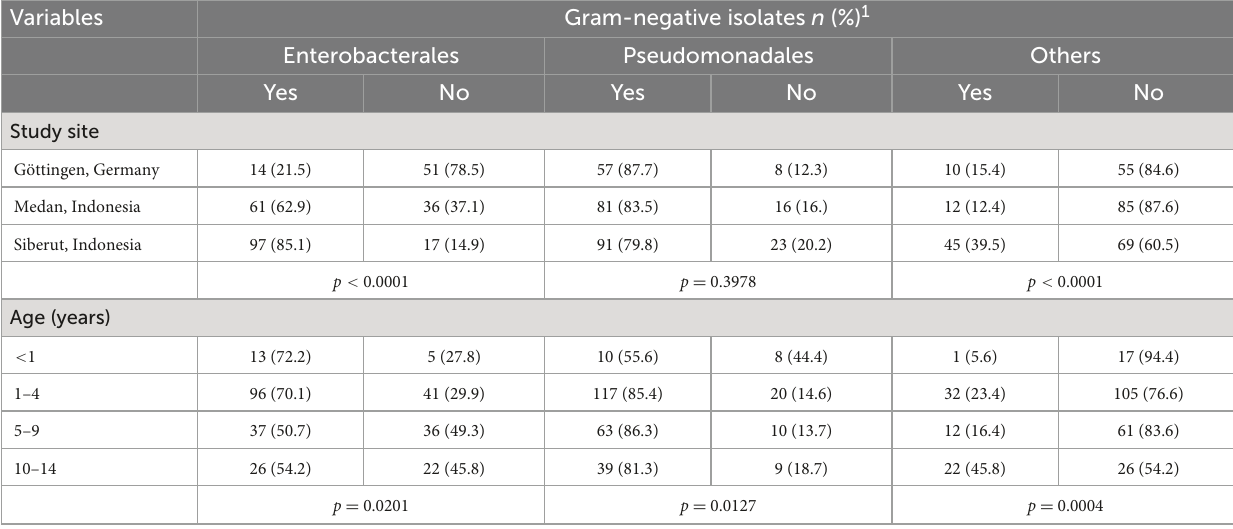
1 Data indicate numbers of bacterial isolates and percentages of hand-contaminated children of the respective study group. Data were analyzed by Chi-square test. P -values of less than 0.05